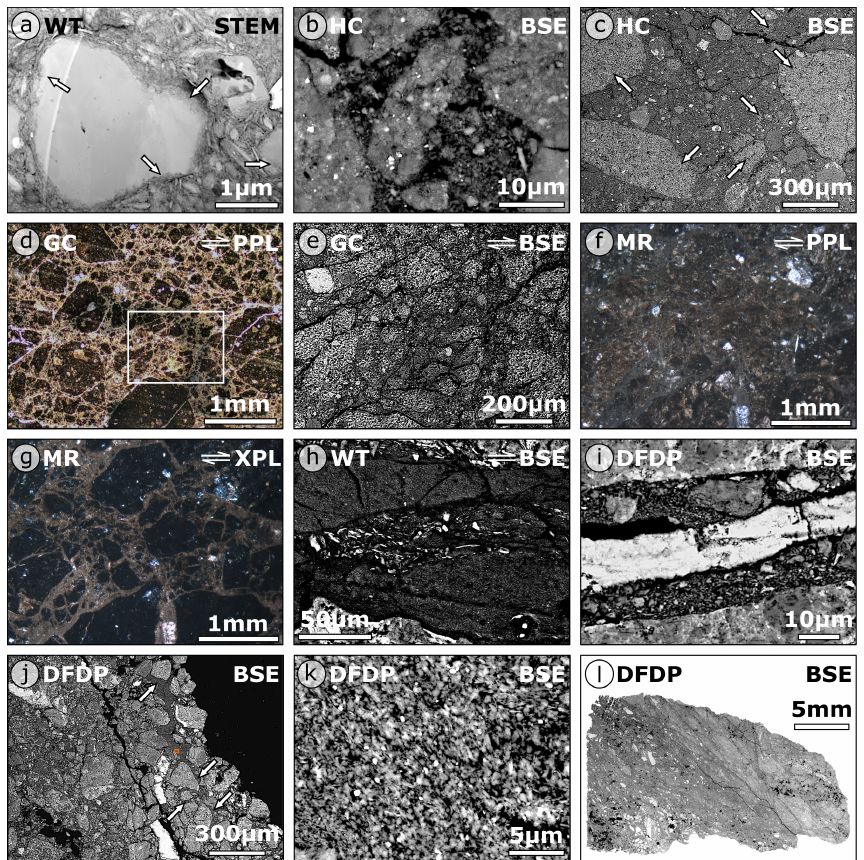
Figure 6. (a) Particles forming the fault rock matrix are defined as smaller than 2µm. Abundant authigenic phyllosilicates cement the matrix. Arrows indicate albite dissolution and alteration to phyllosilicates. (b) Matrix clasts, low-porosity, compact and clast-like areas of similar composition as the matrix, are embedded within the fault rock matrix at all outcrops. (c) Bright matrix clasts (arrows) surrounded by fine- grained matrix and some clasts. (d) Lens of matrix clasts within footwall gravels at Gaunt Creek (see Fig. 5b). The white box indicates location of (e) . (e) SEM analysis shows that clasts within a lens ∼ 8–8.5cm below the PSZ at Gaunt Creek are bright matrix clasts. (f, g) Corresponding PPL (f) and XPL (g) photomicrographs of hanging wall clasts at Martyr River. Identification of constituting mineral